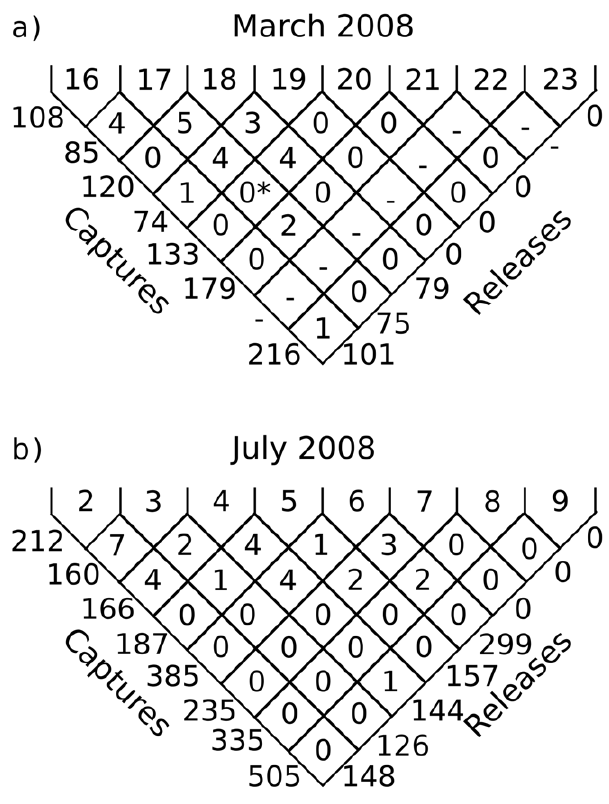
Figure 2. Fisher-Ford trellis plots of mark-release-recapture results obtained in Fourda. For each plot, dates are given along the top of the plot; numbers of mosquitoes marked and released for each date (follow diagonally) are shown along the right edge; numbers of mosquitoes captured are along the left edge. Numbers between these two edges represent the number of marked mosquitoes recaptured, which can be identified by cohort. See the text for further details. (a) Dry season; (b) Wet season. * Landing catch was conducted in Fourda the evening of March 20 with four collectors; four marked An. gambiae were recaptured, all having been released on March 17. These are not included in the analysis.